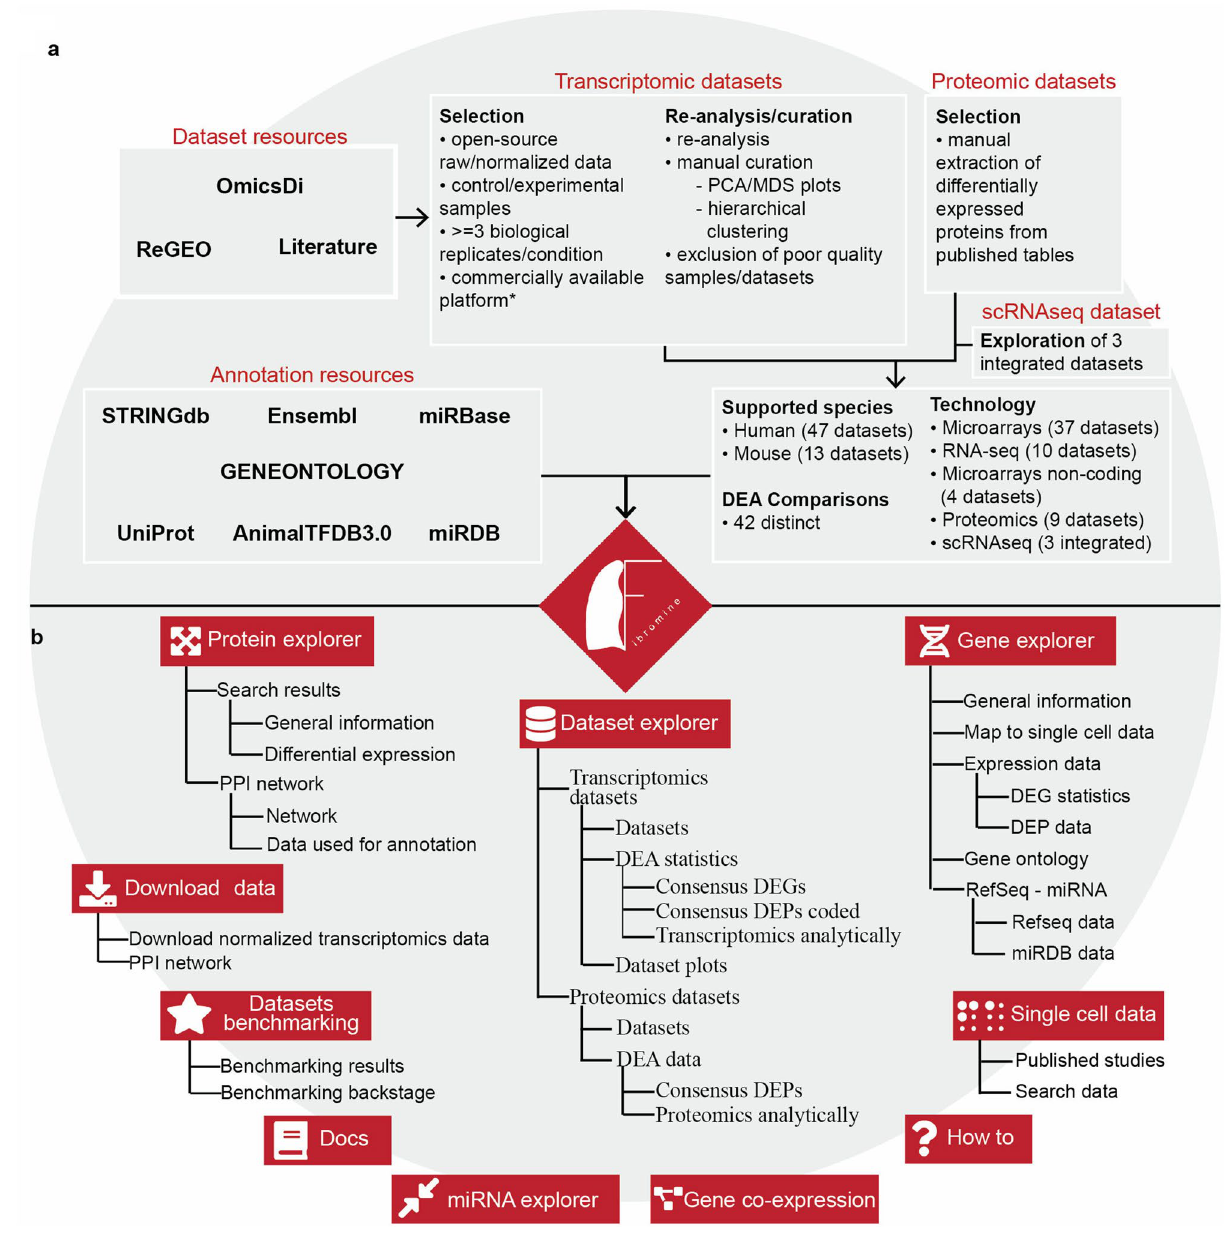
Figure 1. Fibromine database creation workflow and homonymous web server map. (a) Fibromine included datasets were discovered via literature, https:// www. omics di. org/ and http:// www. regeo. org/ scrutiny prior to specific criteria-based selection. Transcriptomic datasets were re-analysed and manually curated, while differentially expressed proteins were gleaned from respective publications. Differential expression was performed in a collection of three integrated scRNA-seq datasets. Annotation was sourced from various open- access resources. (b) Fibromine web interface is Shiny-powered. It is made out of three main explorers Dataset , Gene and Protein explorer and several smaller ones, while Datasets benchmarking tab provides a metrics-based system of datasets accreditation. Single cell data tab provides a list of relative published studies along with DEA results from three integrated datasets. The user can also map a gene directly to several single cell datasets via Gene explorer . MDS: multi-dimensional scaling, PCA: principal component analysis. Annotation sources: https:// string- db. org/, https:// ensem bl. org/, https:// mirba se. org/, http:// geneo ntolo gy. org/, https:// unipr ot. org/, http:// bioin fo. life. hust. edu. cn/ Anima lTFDB/, http:// mirdb. org/. Figure was created using https:// www. google. com/ slides/